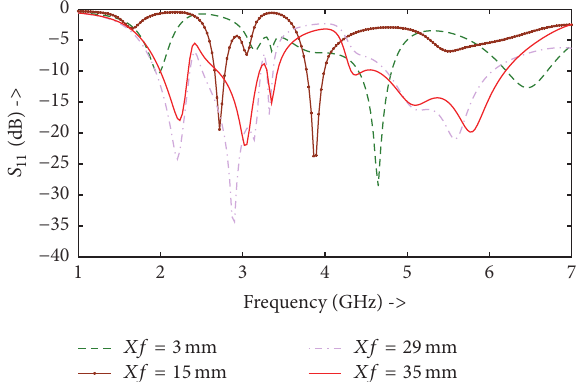
Figure 10: Reflection coefficient of different location of feeding pin.